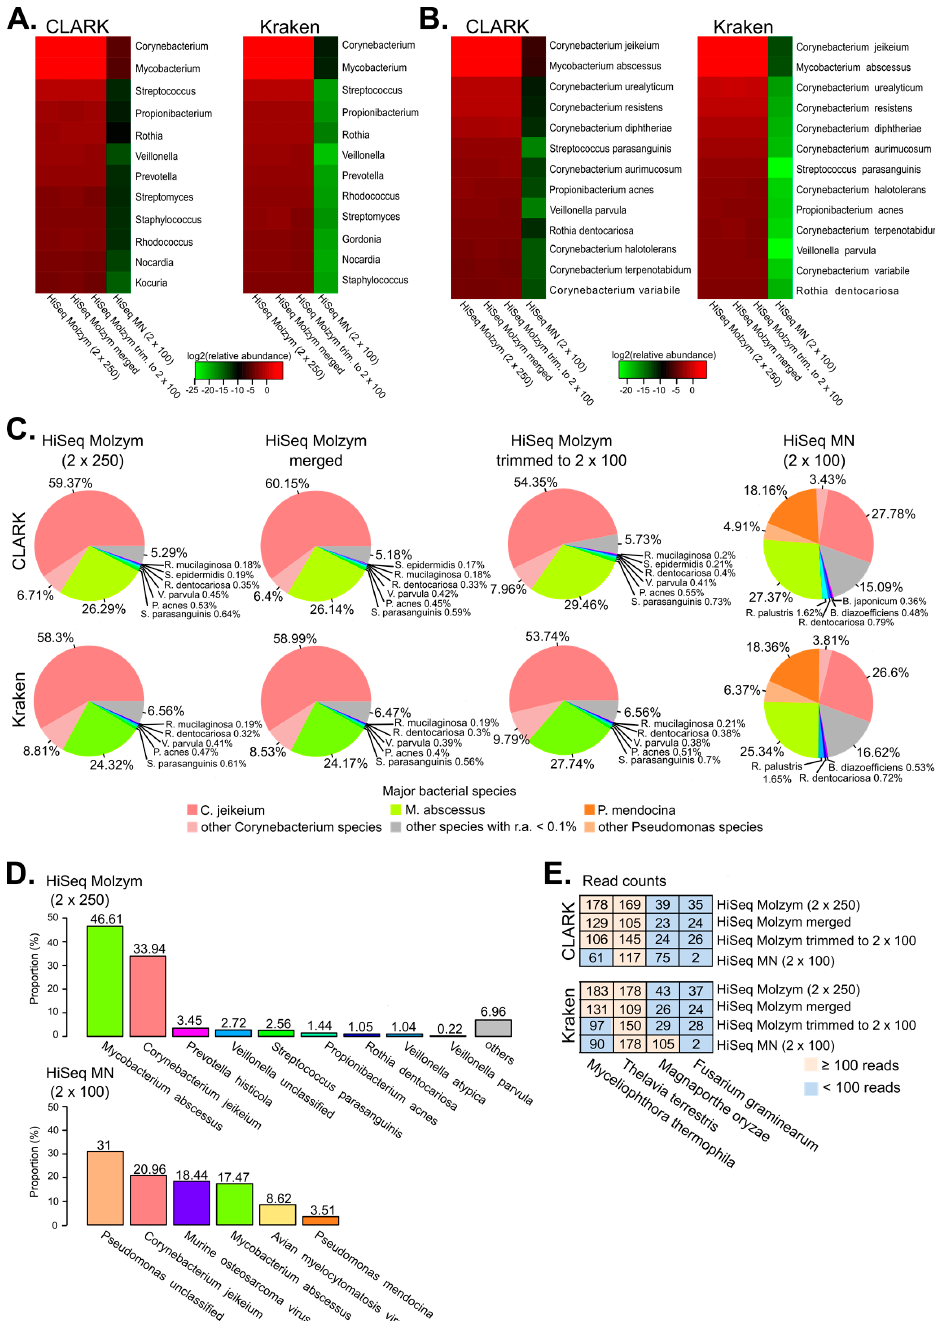
Figure 2. Heat maps reporting the log2-transformed relative abundance of the 15 most abundant bacterial genera ( A ) and the 16 most abundant bacterial species ( B ) identified by CLARK and Kraken in all sequencing datasets. Relative abundance, expressed in percentage, is computed on the number of reads assigned to a given genus or species divided by the total number of sequencing reads present in a given dataset; ( C ) Pie charts representing the bacterial proportions of identified species as performed by CLARK (top) and Kraken (bottom). Bacterial proportions are defined as the percentage of reads mapped to a given bacterial species over the total number of reads assigned to prokaryotes; ( D ) Barplots showing relative abundance (%) of bacterial and viral taxa identified by MetaPhlAn2 in HiSeq Molzym, and HiSeq MN sequencing data. Percentage values are reported at the top of each bar; ( E ) Heat map representing the number of reads assigned to the most abundant fungi. Numbers indicate read counts instead of proportions.